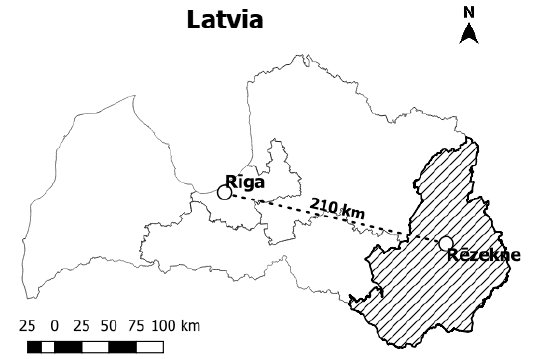
Figure 1. Map with the observation location.